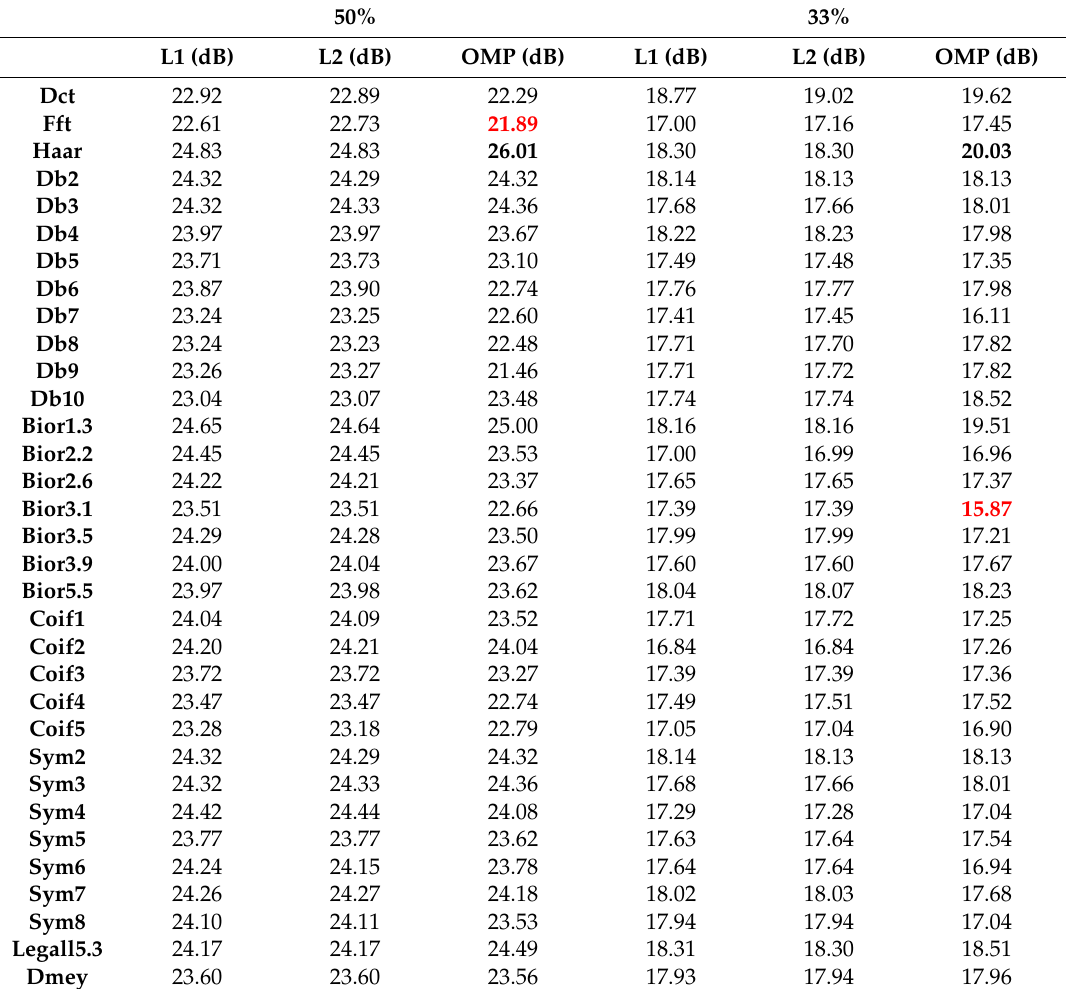
Table 1. PSNR calculated with different bases and recovery methods for experimental data acquired at the test site “Campus”